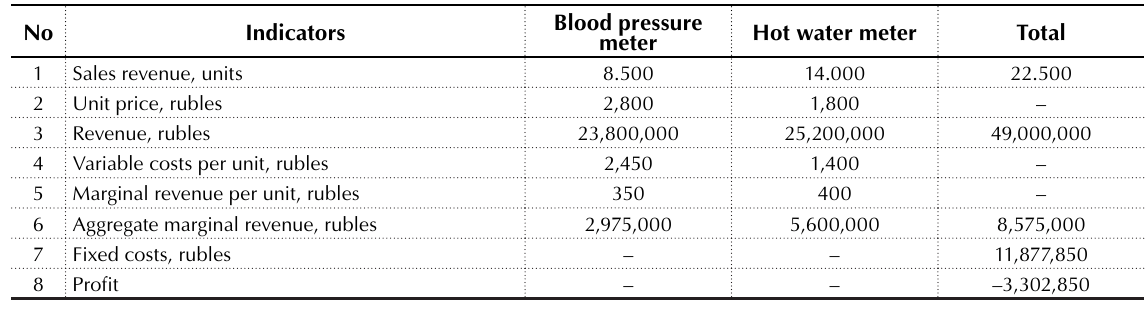
Table 5. Information characterizing the activity of the enterprise at the current production output and prices for products called blood pressure meter and hot water meter at the same level